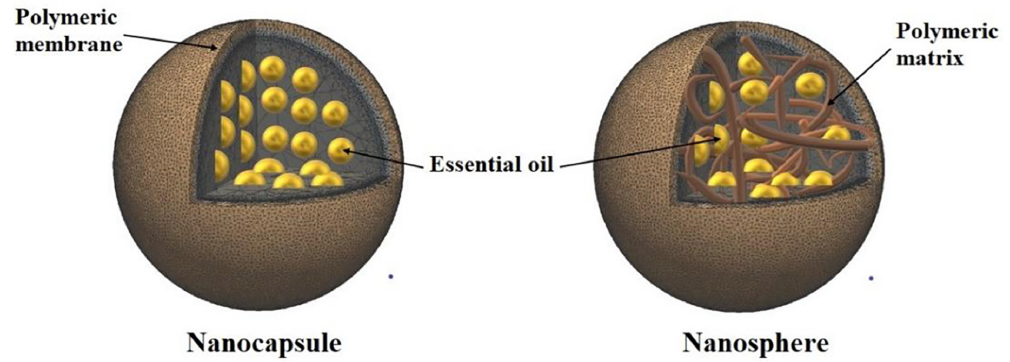
Figure 2. Di ff erent types of polymeric Figure 2. Different types of polymeric nanoparticles.